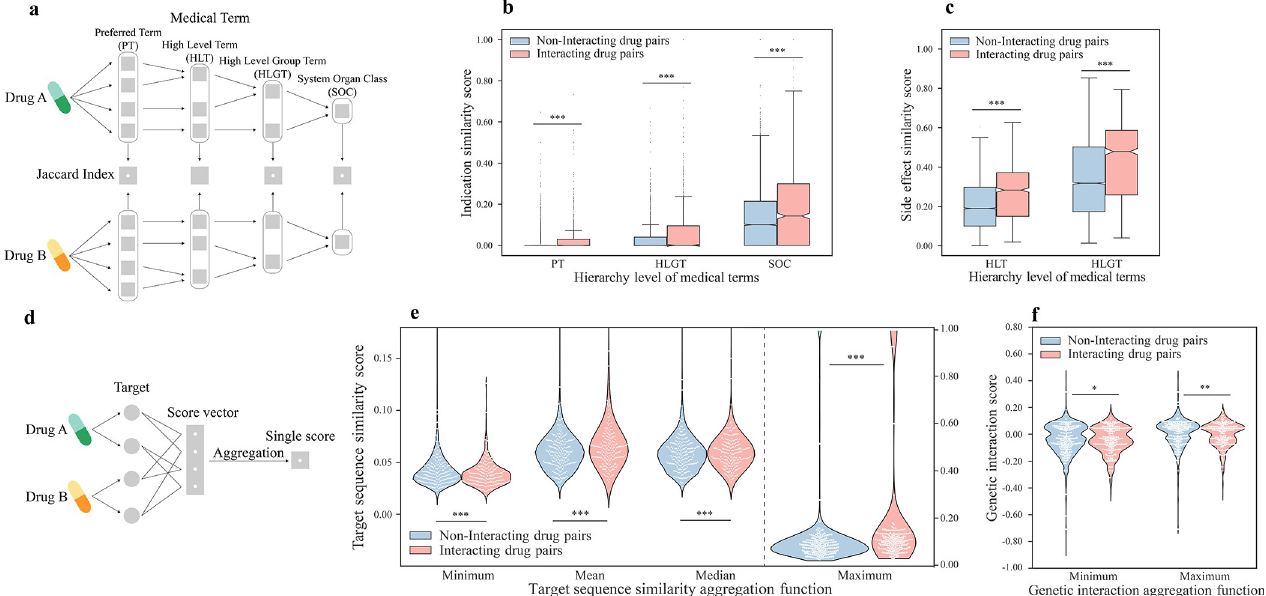
Fig 1. Adversely interacting drug pairs and non-interacting drug pairs significantly differ with regard to the 11 features selected. (a) Schematics of calculating indication similarity and side effect similarity features. (b) Indication similarity score of hierarchy level PT, HLGT and SOC between two drugs. (c) Side effect similarity score of hierarchy level HLT and HLGT between two drugs. (d) Schematics of calculating target sequence similarity and genetic interaction features. Genetic interaction scores indicate the deviation from the expected phenotype when two genes are simultaneously knocked out, and were obtained from a global genetic interaction network in yeast by mapping targets of drugs to their yeast homologs. A negative score denotes synergistic interaction while a positive score indicates buffering interaction. (e) Minimum, mean, median and maximum target sequence similarity score between targets of two drugs. (f) Minimum and maximum genetic interaction score between targets of two drugs. Statistical significance was determined by the two-sided permutation test on the sample mean. PT, preferred term; HLT, high level term; HLGT, high level group term; SOC, system organ class. � p < 0.001; �� p < 0.0001; ��� p <